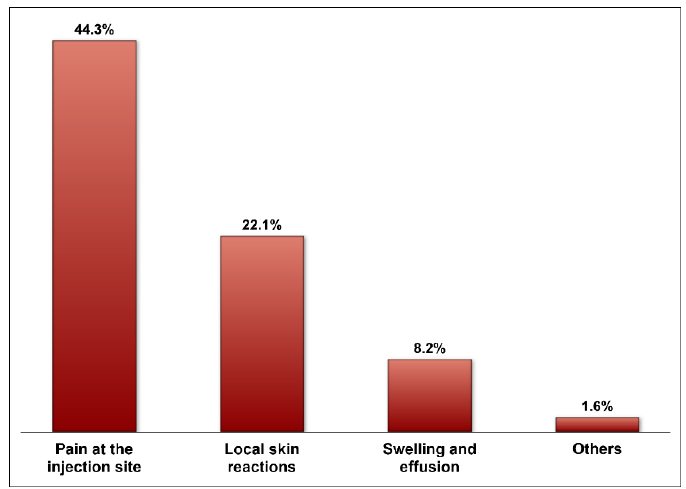
Figure 4. The commonly reported side effects of hyaluronic acid injections.